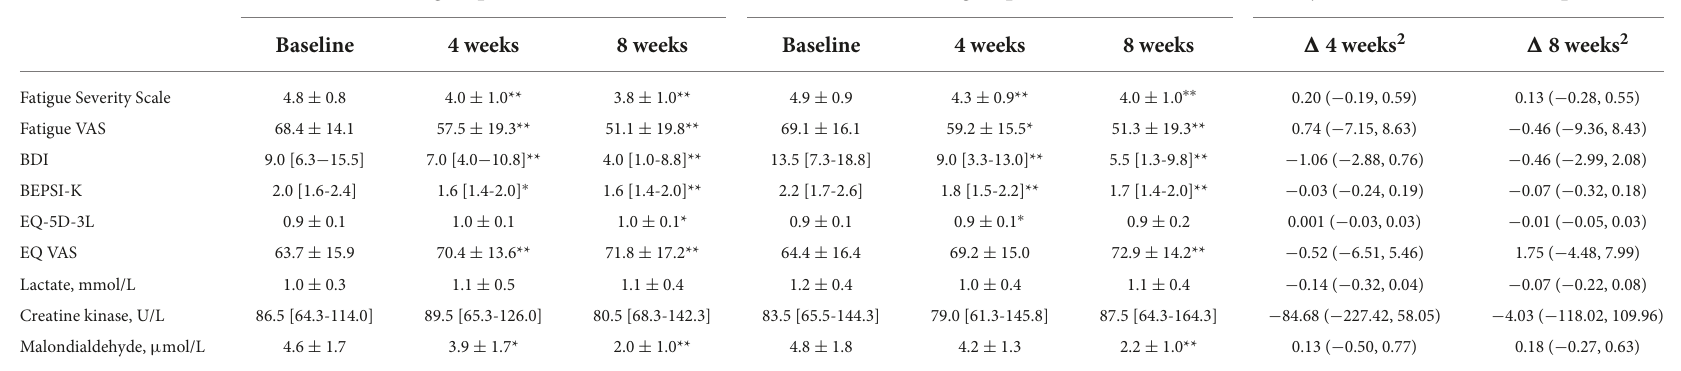
TABLE 2 Primary and secondary outcomes (intention-to-treat population) 1 .